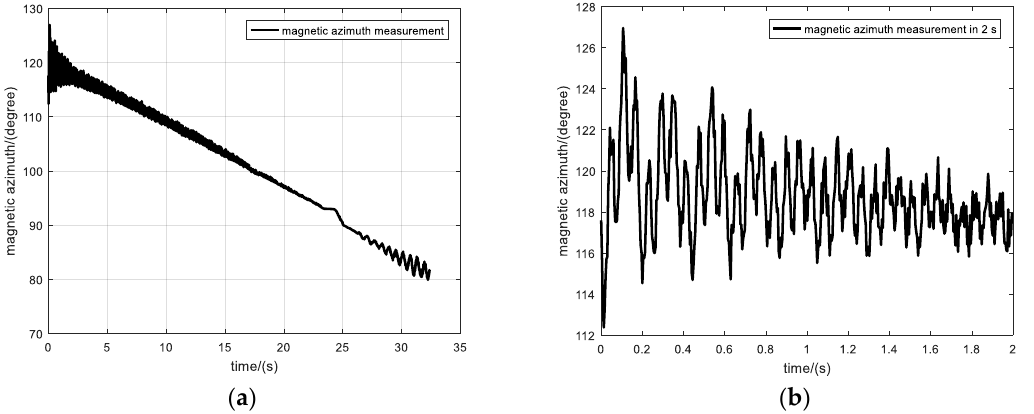
Figure 14. The magnetic azimuth calculated using the zero-crossing method. ( a ) Magnetic azimuth, ( b ) Magnetic azimuth in 1s .